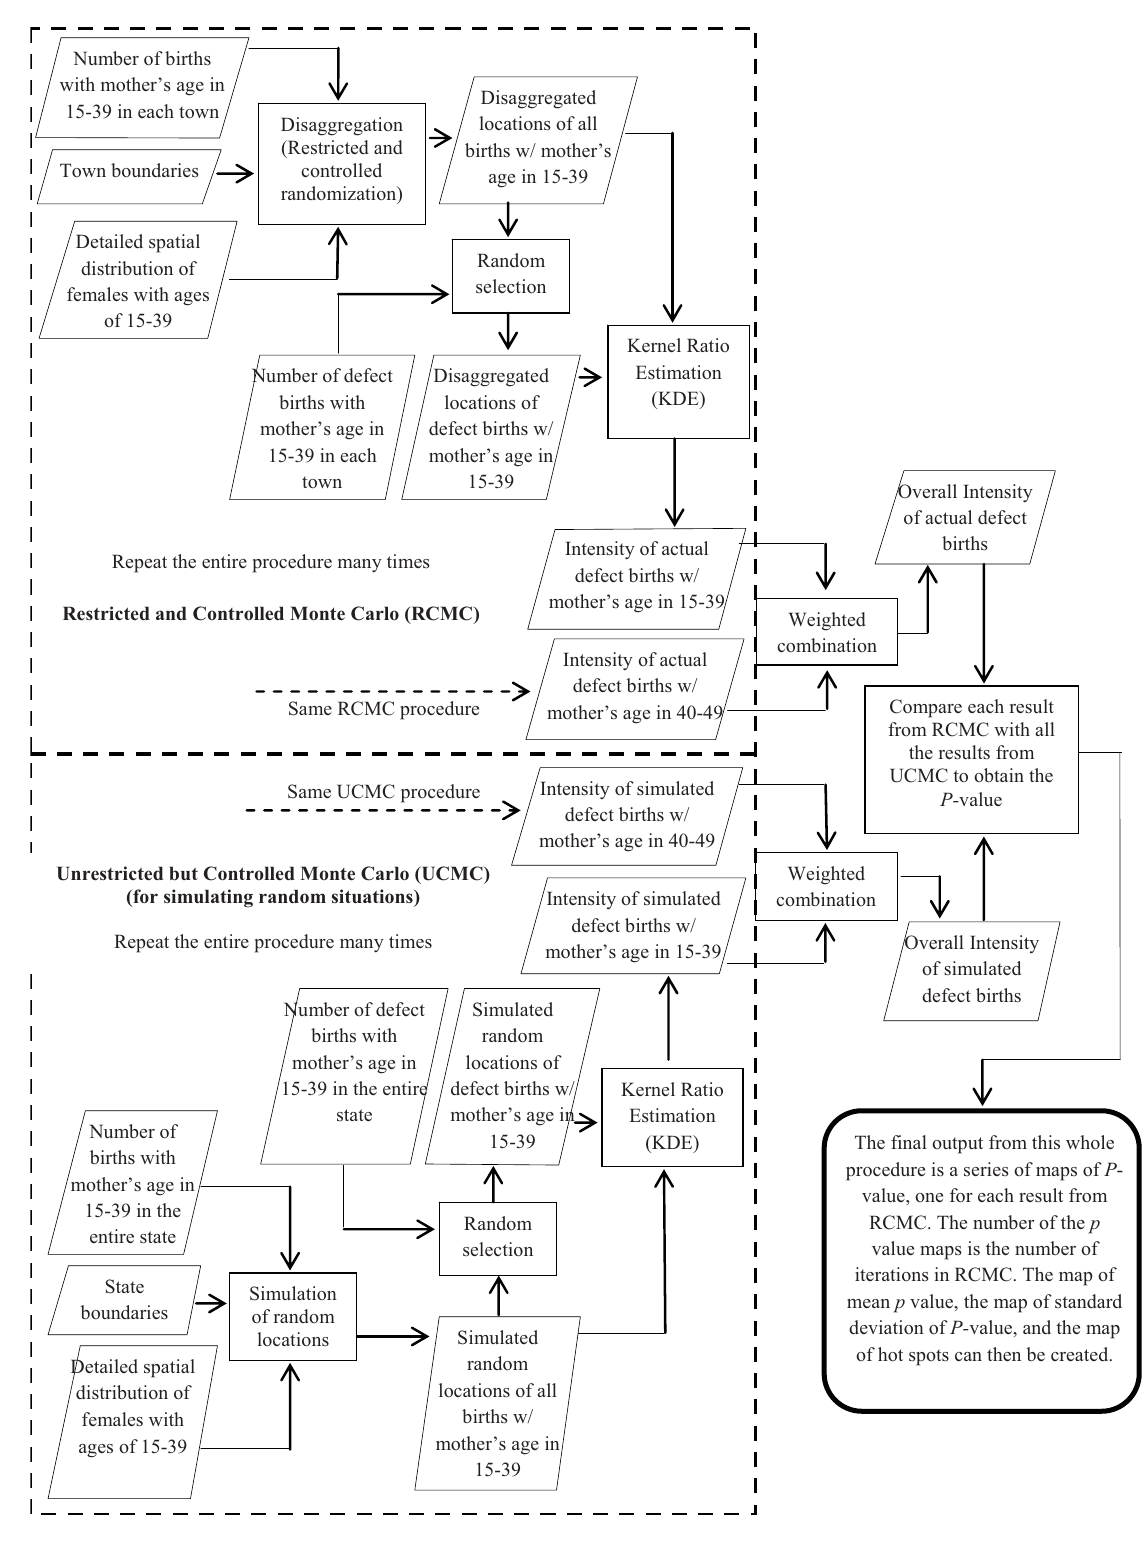
Figure 3. The procedure of disease mapping using the Restricted and Controlled Monte Carlo (RCMC): using birth defect mapping for New Hampshire as an